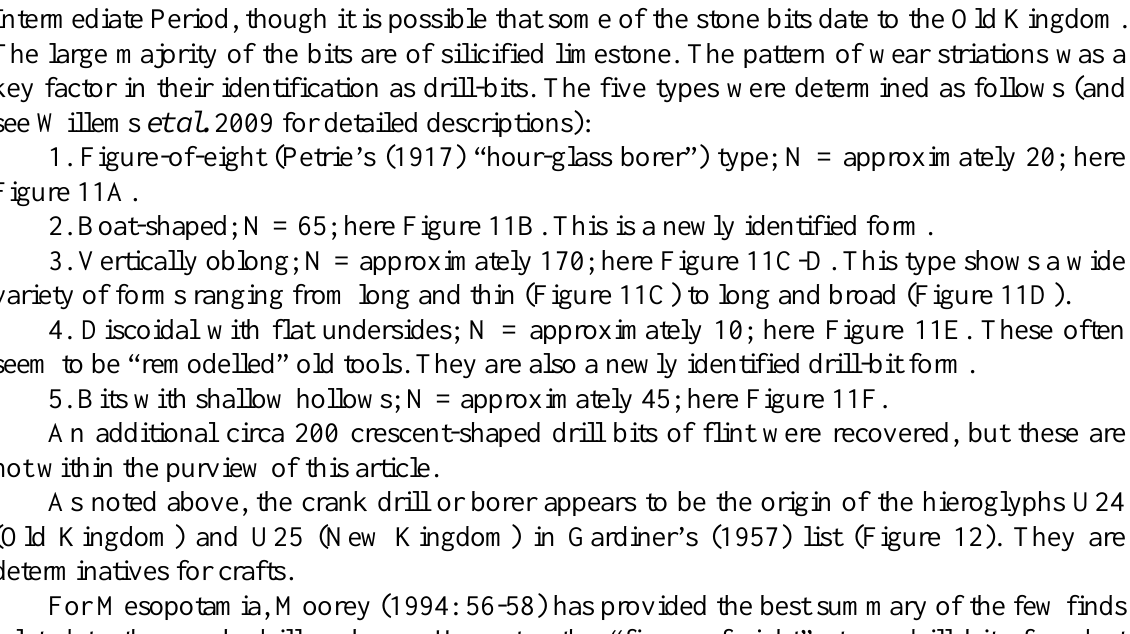
1. Figure-of-eight (Petrie’s (1917) “hour-glass borer”) type; N = approximately 20; here Figure